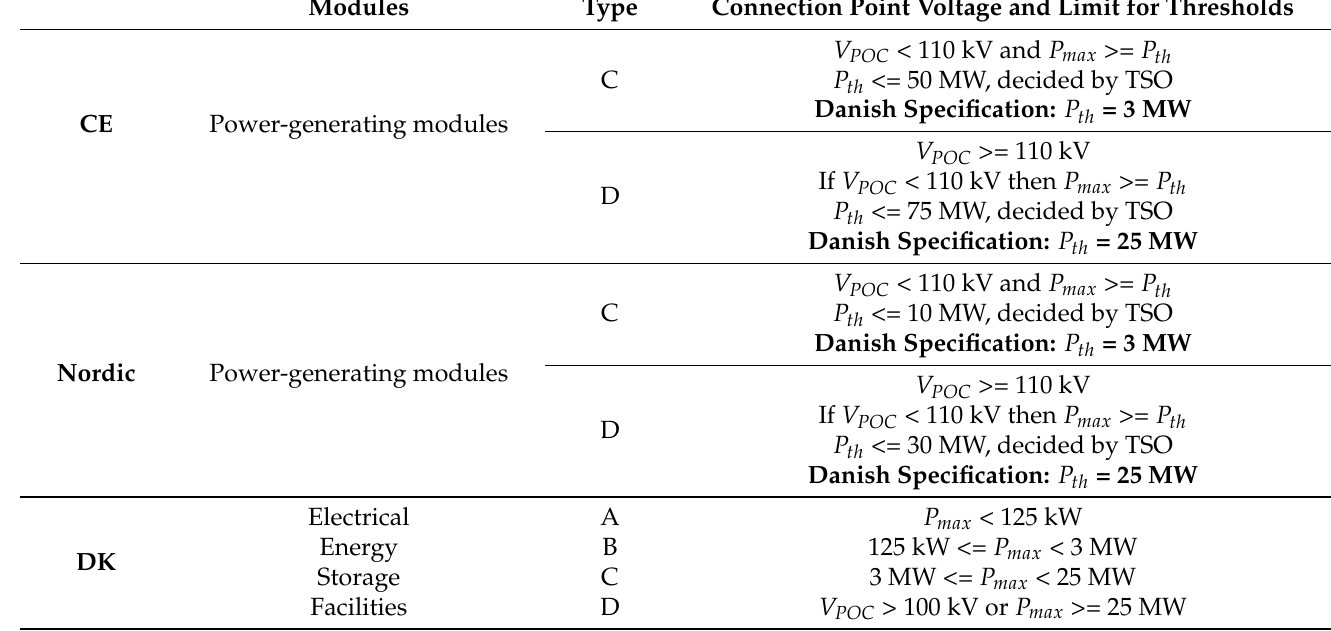
Table 1. Sizes of power-generating modules as per Commission Regulation (EU CR) for Continental Europe (CE) and Nordic power system and Danish specifications (Denmark denoted by DK) for electrical energy storage facilities with respect to utility scale